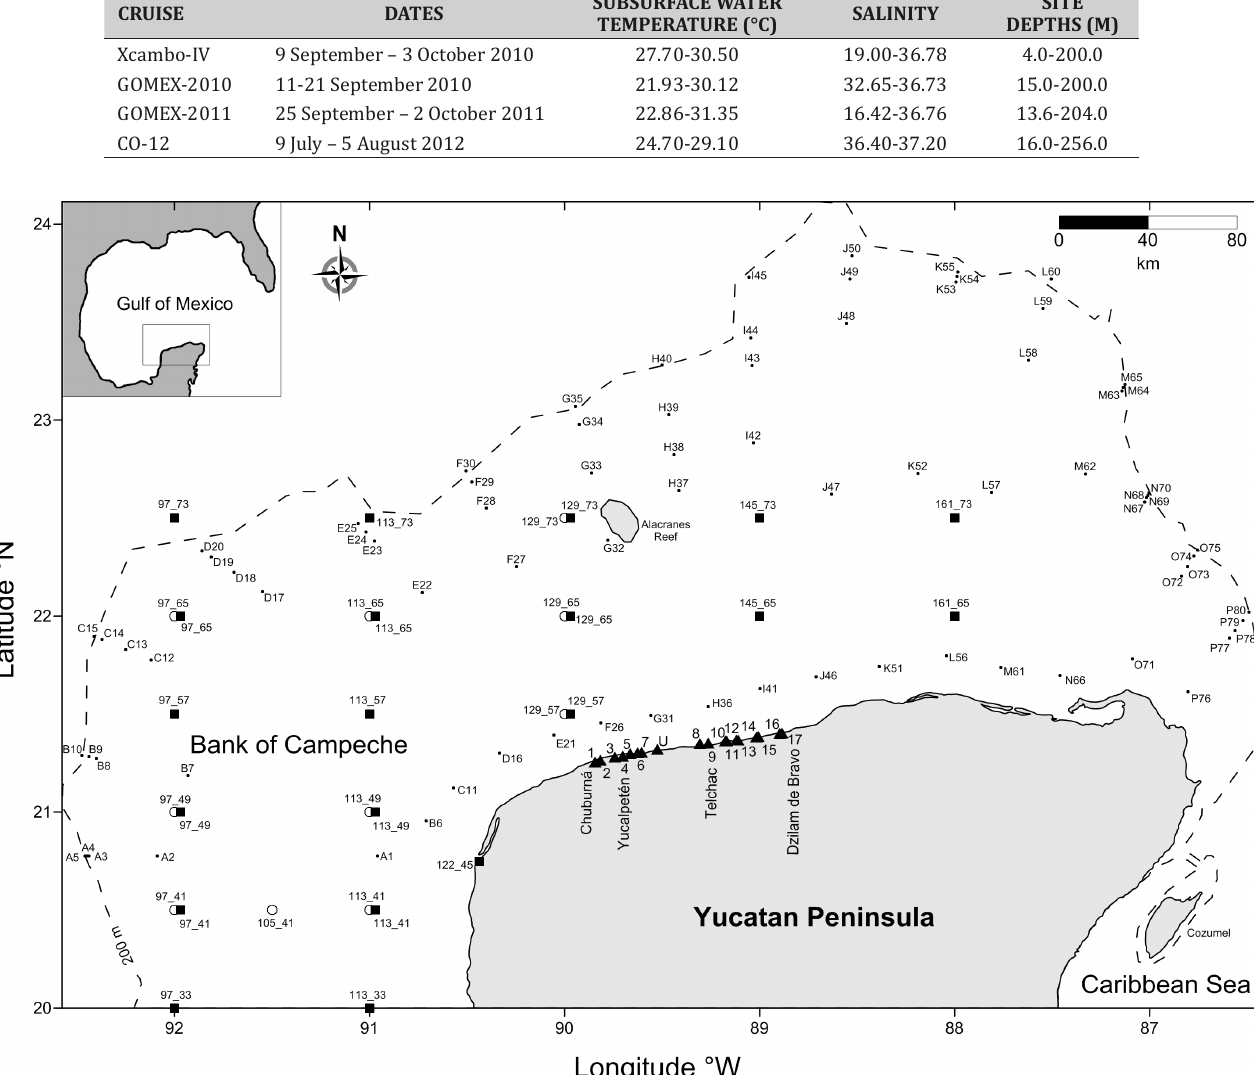
Hydrological (at 10 m depth) and bathymetrical data on oceanographic cruises around the northern Yucatan